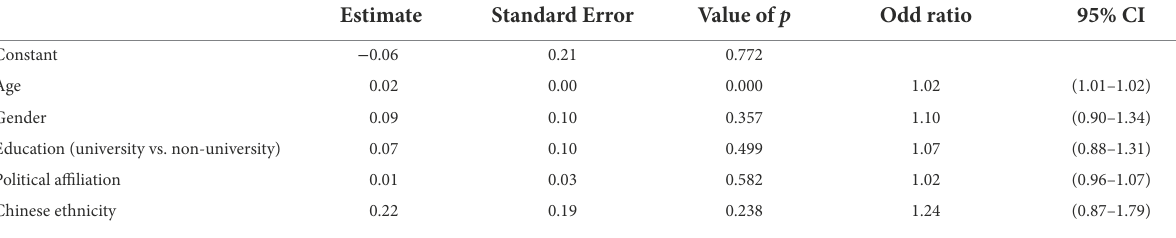
TABLE 3 Coefficients for the binary logistic regression predicting participation at wave